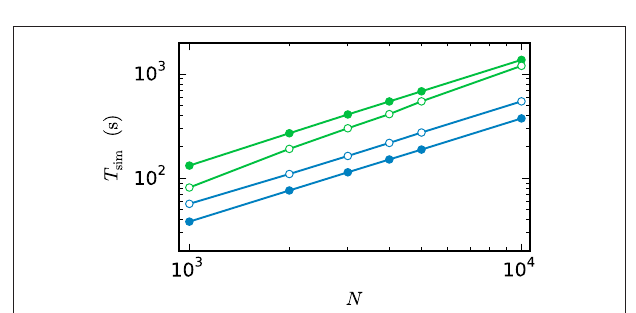
FIGURE 12 | Comparison of simulation times on different systems. Simulation of the scaled version of the pair of neurons (Test case 1 b) with different network sizes. Open symbols show the results for communication in every step ( T = h ) while filled symbols show the results for the original NEST communication scheme ( T = d min ). The simulations on the workstation (green) are executed with 8 virtual processes ( 8 threads). The JUQUEEN simulations (blue) use 128 virtual processes ( 16 MPI processes a 8 threads). 500 ms of biological time are simulated with step size h = 0 . 05ms